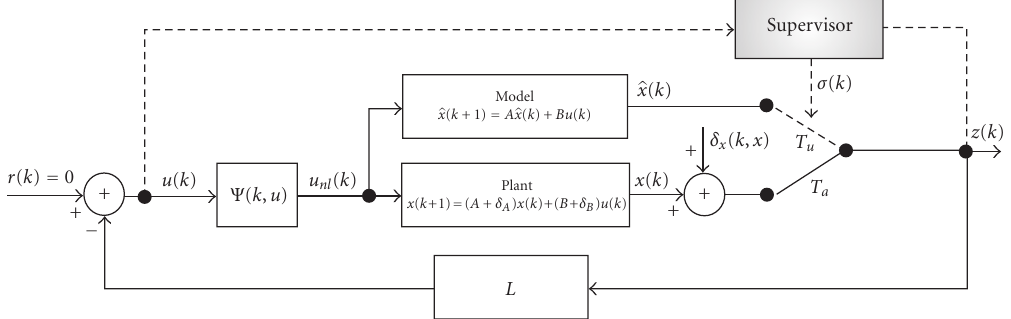
Figure 1: Block diagram of a discrete feedback system with nonlinear actuator and interrupted observations supervisor.